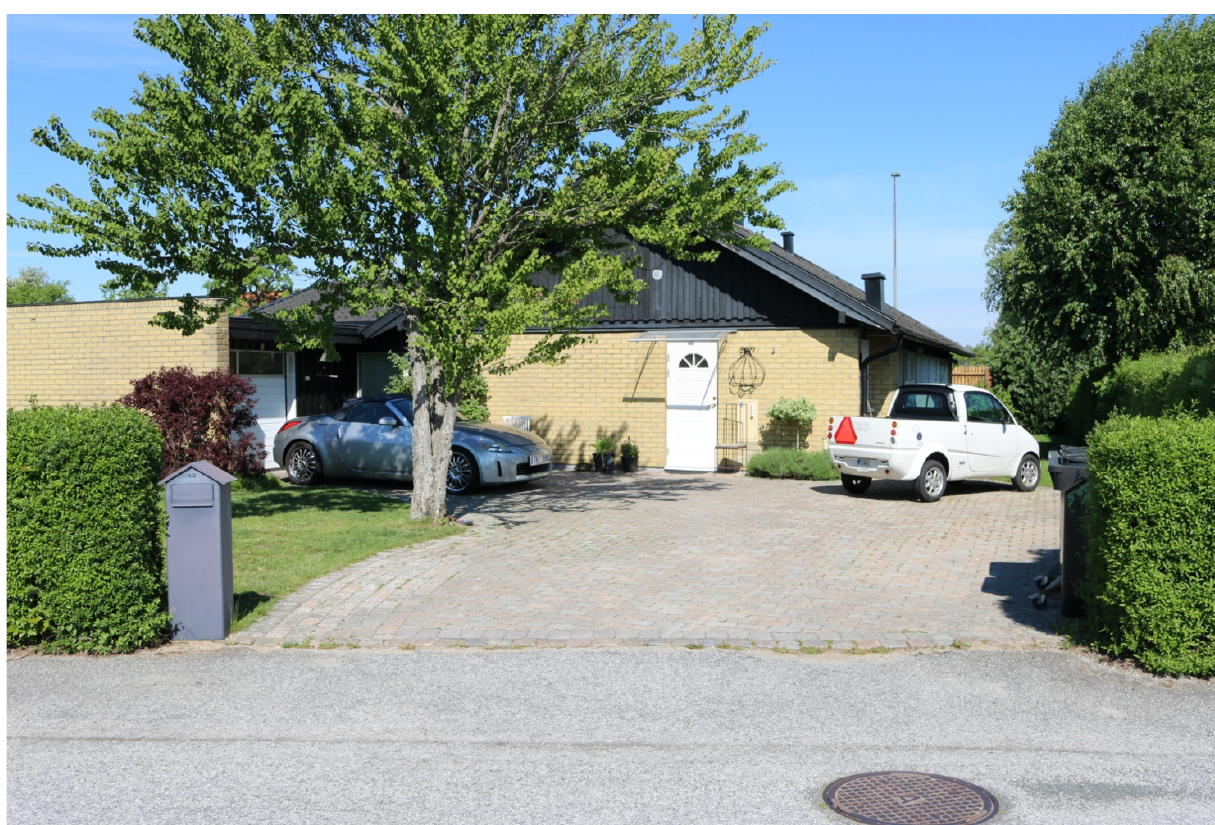
Figure 2. Cars in a driveway in the part of Stångby that was built in the 1960s. Source: Author.